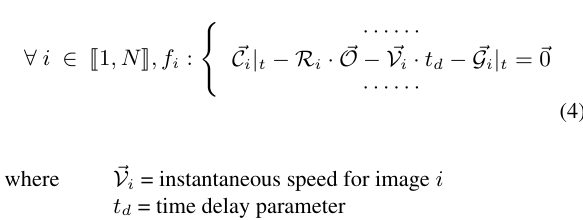
Figure 10: Residuals of GPS estimation of position at each epoch Figure 10 highlights that model fits data well. No trend in residu- als distribution is present. Amplitude of variation is at centimetric level with a constant standard deviation. Next, a measurement of lever-arm vector is performed following the method of pseudo- materialization presented in part 3.3.2. Further to the 7 param- eters of the 3d similarity, electronic delay is estimated while the lever arm value is fixed using system of equations 6 for N im-